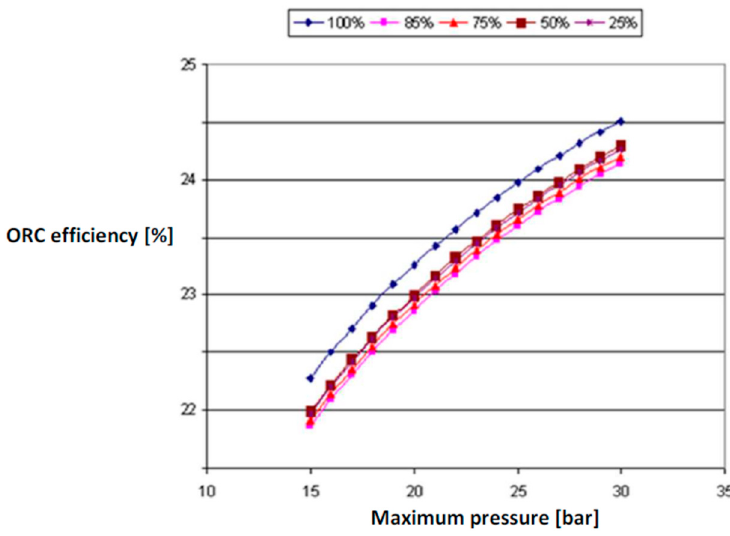
Figure 5. ORC efficiency vs. maximum cycle pressure, for different engine loads (cooling water temperature equal to 38 °C).